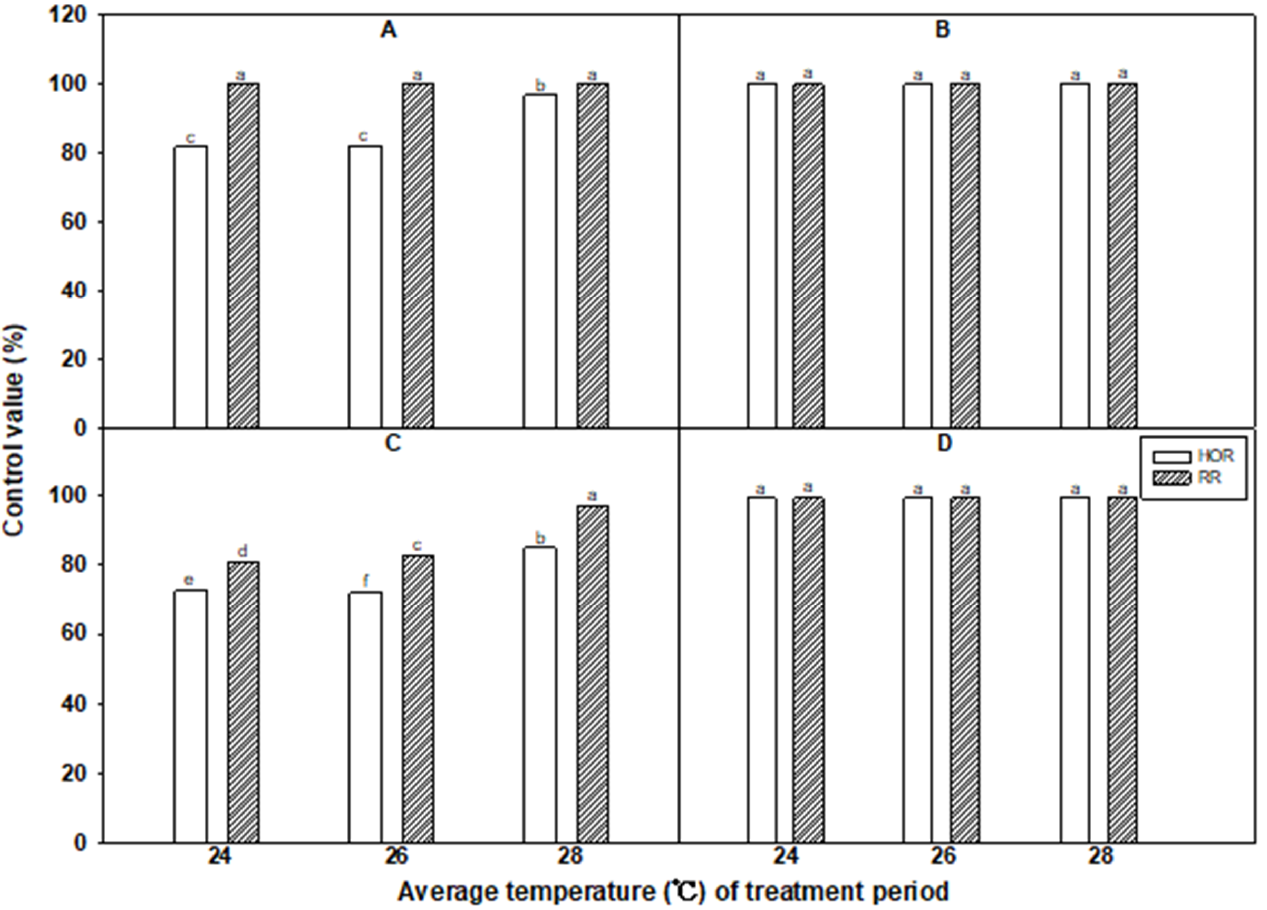
Figure 10. Control value (%) of A. patulus in response to soil-applied herbicides ( A . alachlor; B . metolachlor; C . ethalfluralin; D . linuron) at different average temperatures in greenhouses. HOR: Half of the recommended rate; RR: Recommended rate. Means within bars followed by the same letters are not significantly different at the 5% level according to Duncan’s Multiple Range Test. Error bars represent SE.